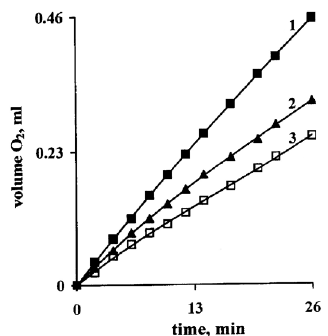
Figure 2: Kinetic curves for TBHP consumption in the epoxidation of 1-octene at 100 o C in the presence of: (1) Ag/MoO Pd/MoO and (4) Cu/MoO . The amounts of reactants and catalysts: 3 3 4 mL (25 mmol) of 1-octene, 0.5 mL (5 mmol) of TBHP, 5.5 mL of chlorobenzene, 0.01 g of catalyst.